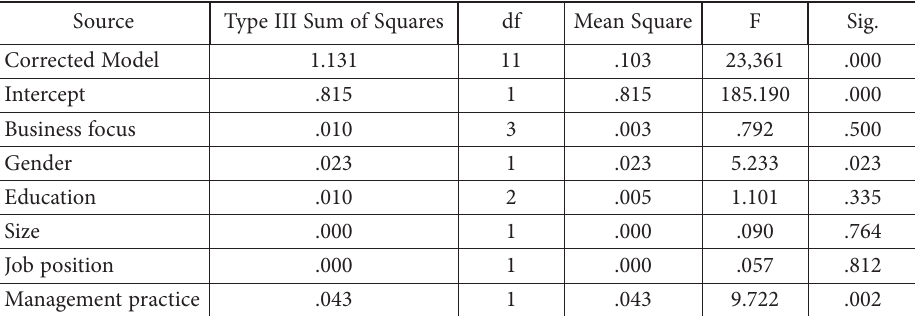
Table 5. Coding of variable categories (source: own research) Source Type III Sum of